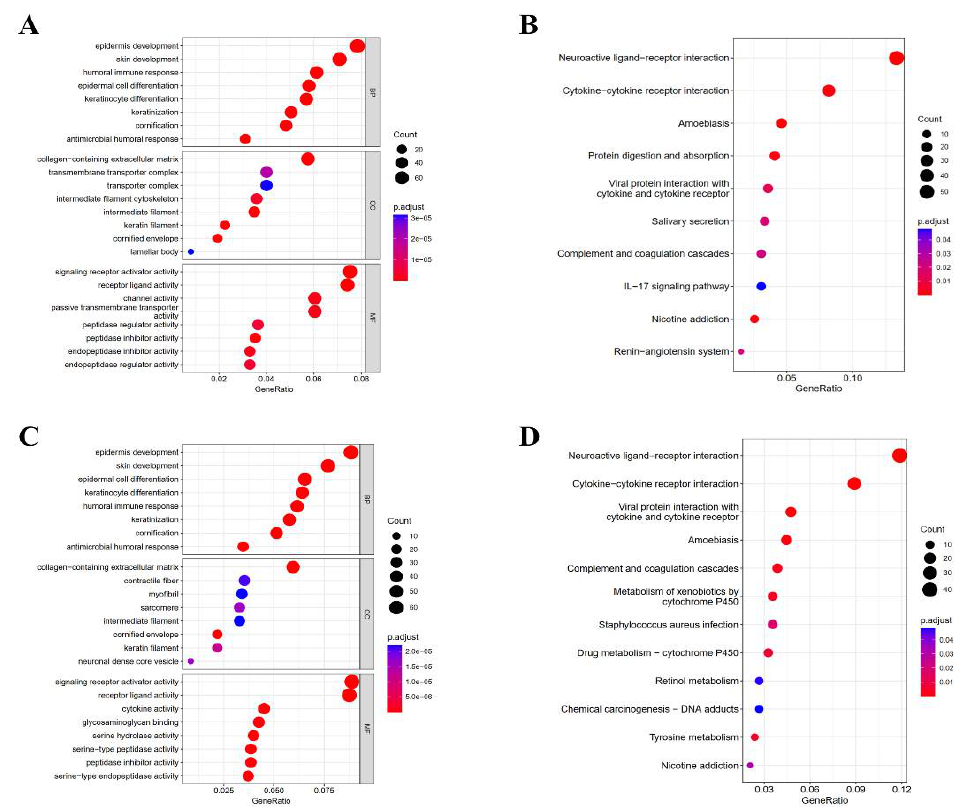
Figure 4. GO and KEGG enrichment analyses of KRT17-correlated genes in BC tissues from the TCGA-BRCA datasets. GO enrichment analysis identified the BP, CC and MF terms enriched by the genes coexpressed with KRT17 in HER2 high ( A ) and ER high ( C ) BC. KEGG pathway analysis of genes coexpressed with KRT17 in the HER2 high ( B ) and ER high ( D ) BC cohorts.